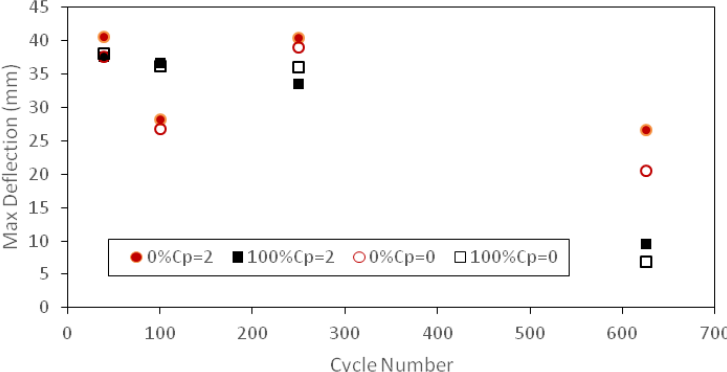
Figure 13. Max. deflection vs. number of cycles under 100 °C but different humidity levels (0% and 100%) and different cycle periods (Cp = 0 and 2).